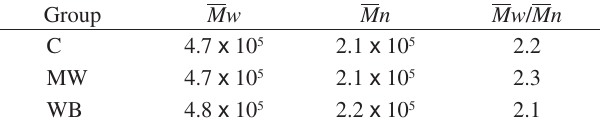
Table 4. Number average molecular weight ( M n), weight average molecular weight ( M w), and polydispersivity ( M w/ Mn ) of K specimens after polymeriza- tion (C), and after the two post-polymerization treatments (MW and WB). Group